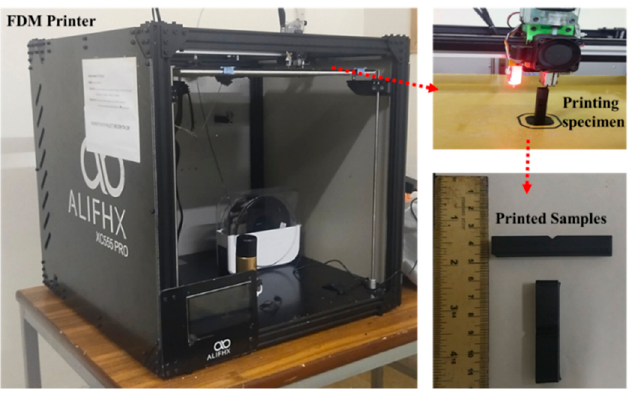
Figure 2. FDM 3D printer, specimen printing, and test samples.